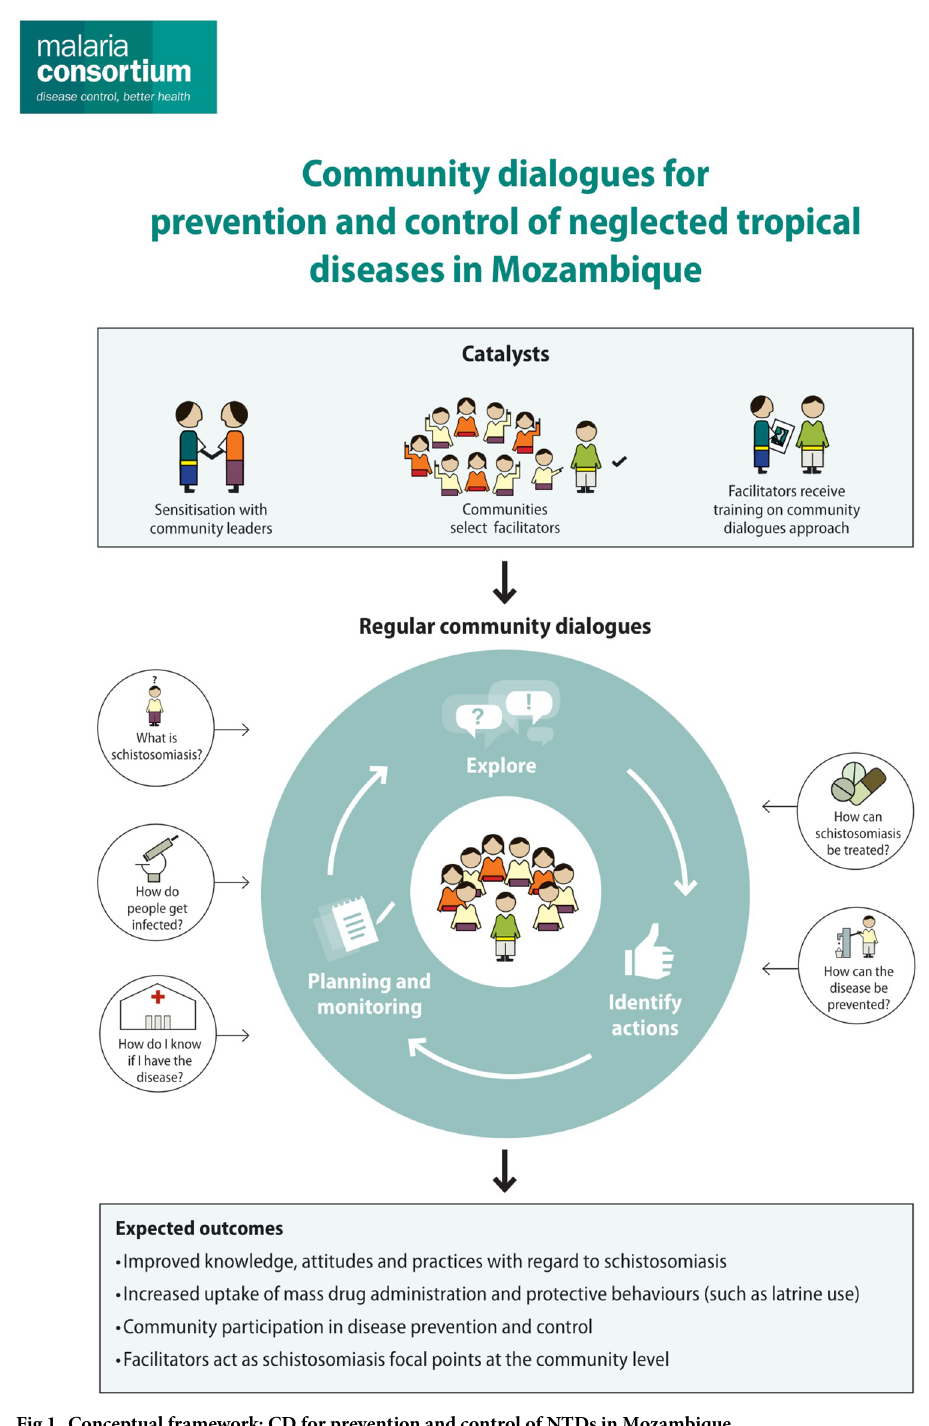
Fig 1. Conceptual framework: CD for prevention and control of NTDs in